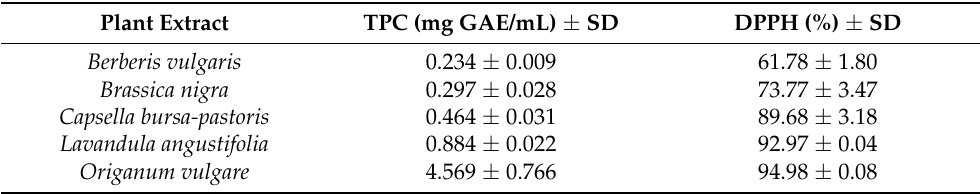
Table 2. The 2,2-diphenyl-1-picrylhydrazyl (DPPH) antioxidant activity and total phenolic content (TPC) of plant